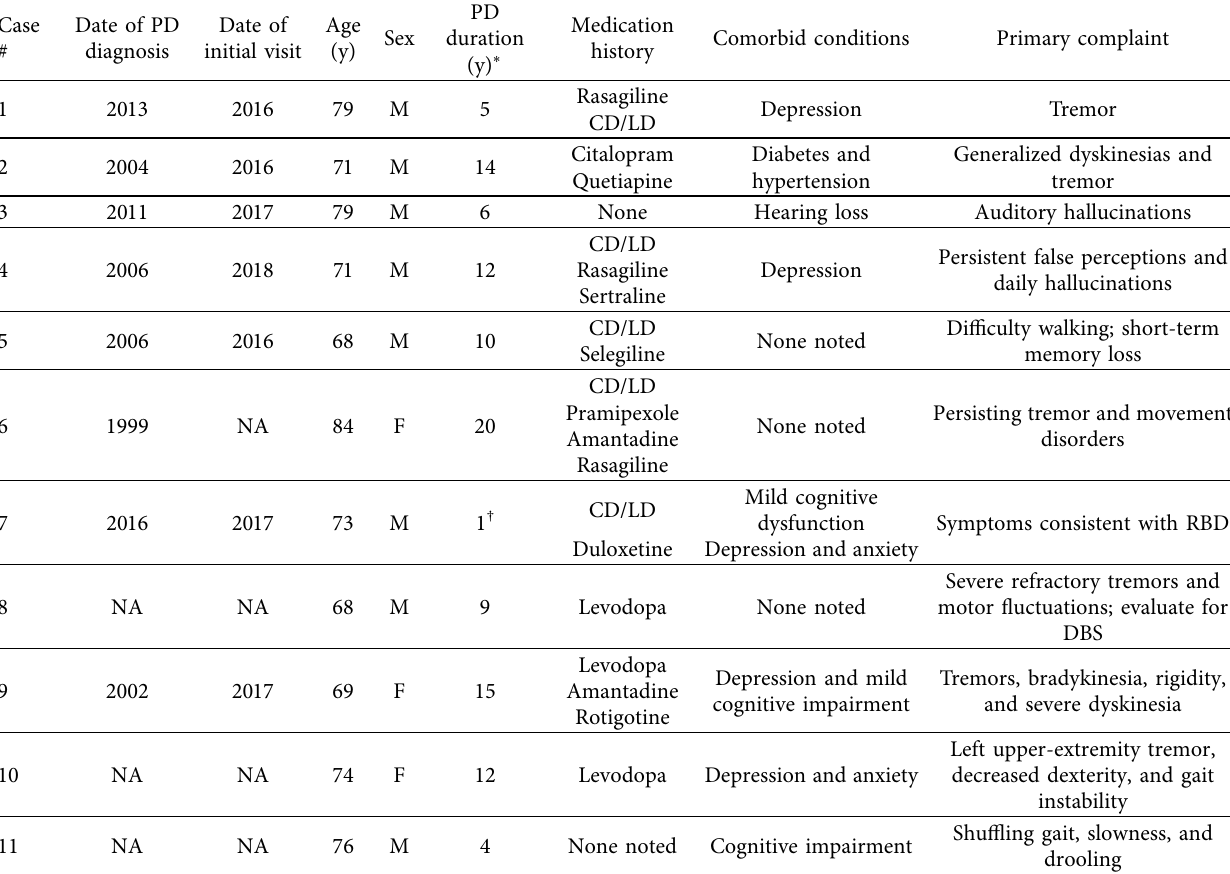
Table 1: Summary of 11 cases of Parkinson’s disease